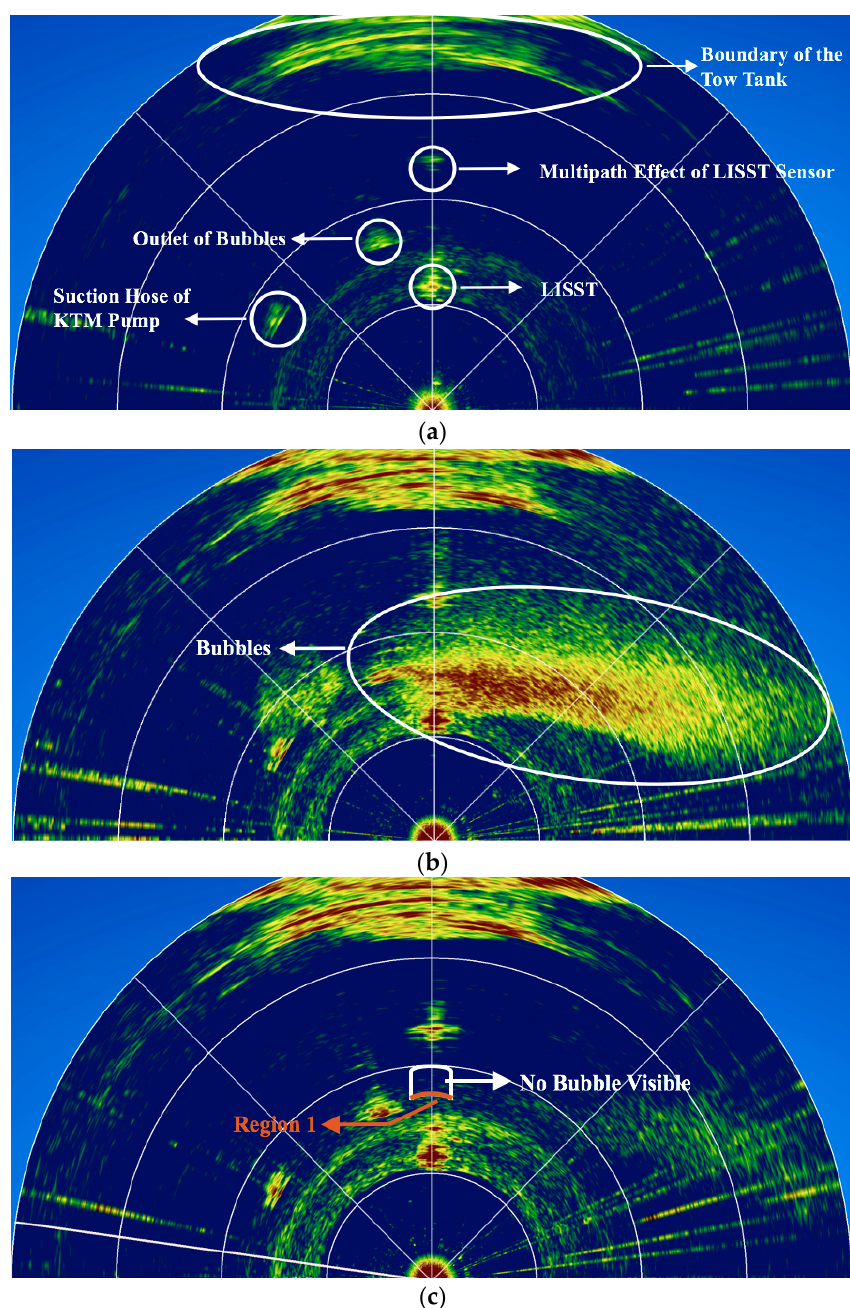
Figure 14. Sonar image collecting at sampling position 3 ( a ) before the start of the bubble generator ( b ) with the bubble generator working ( c ) and a when there was no plume on the vertical plane for calculating residence time.